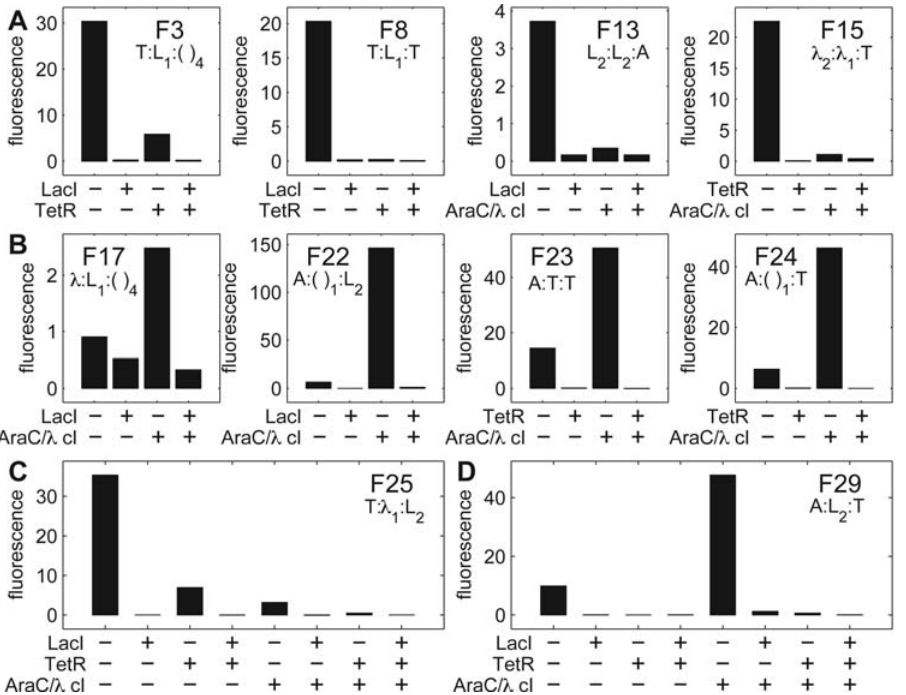
Figure 5. Bar plots of specific promoters shown in Fig. 3. (A) Two-input NOR promoters. (B) Two-input ANDN promoters. (C) Three-input NOR promoter. (D) Three-input ANDN promoter.